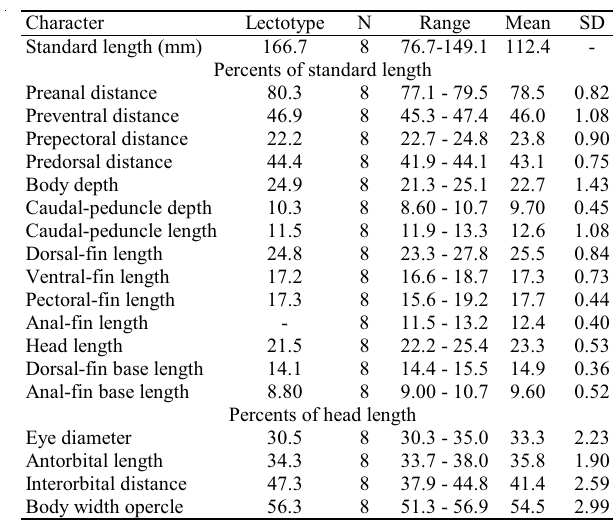
Table 4. Morphometrics of Laemolyta orinocensis